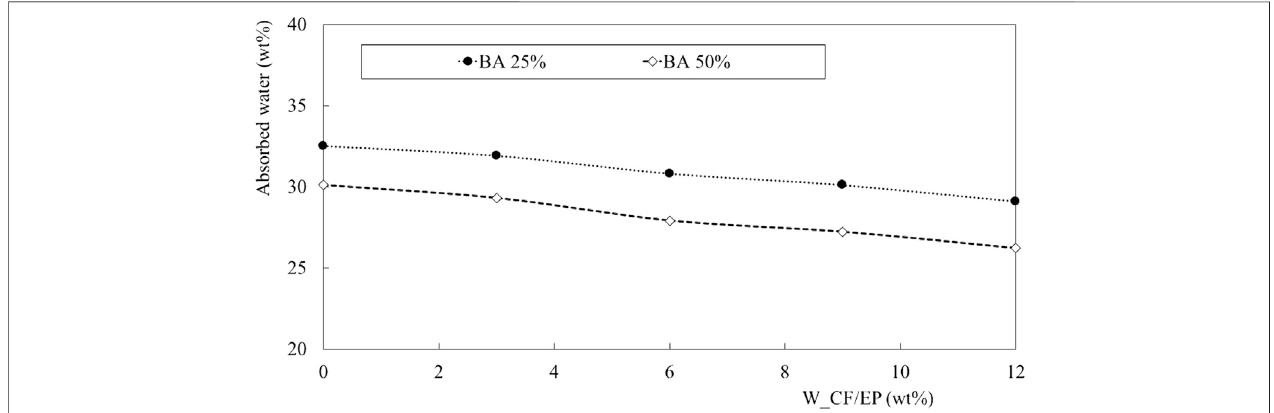
FIGURE 4 | Water absorption of all the investigated